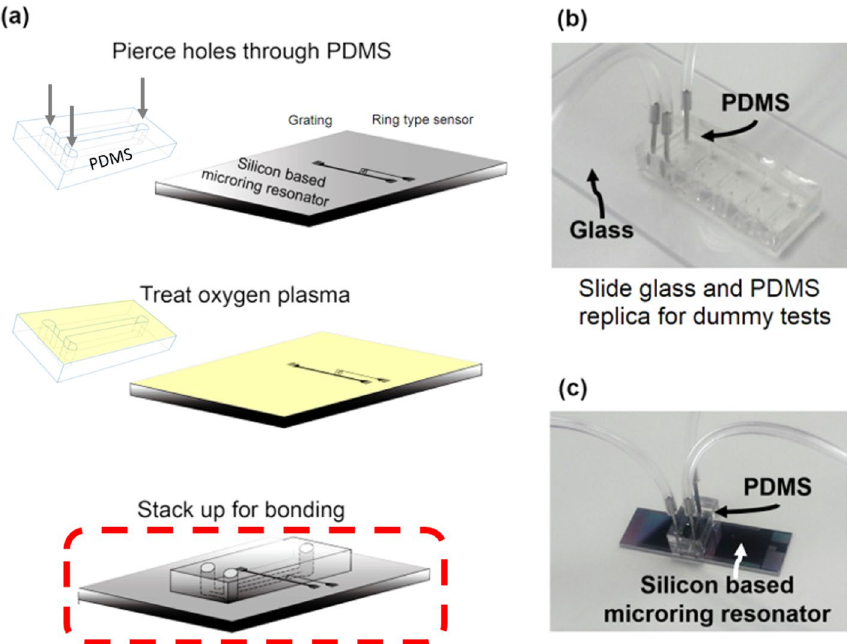
Figure 2. ( a ) Schematic diagram of fabrication of a silicon-based label-free optical biosensor. For bonding, O 2 plasma was used. Images of; ( b ) fabricated PDMS/glass microfluidic device by replacing the silicon-based microring resonator with the glass for dummy test and ( c ) the fabricated silicon-based label-free optical